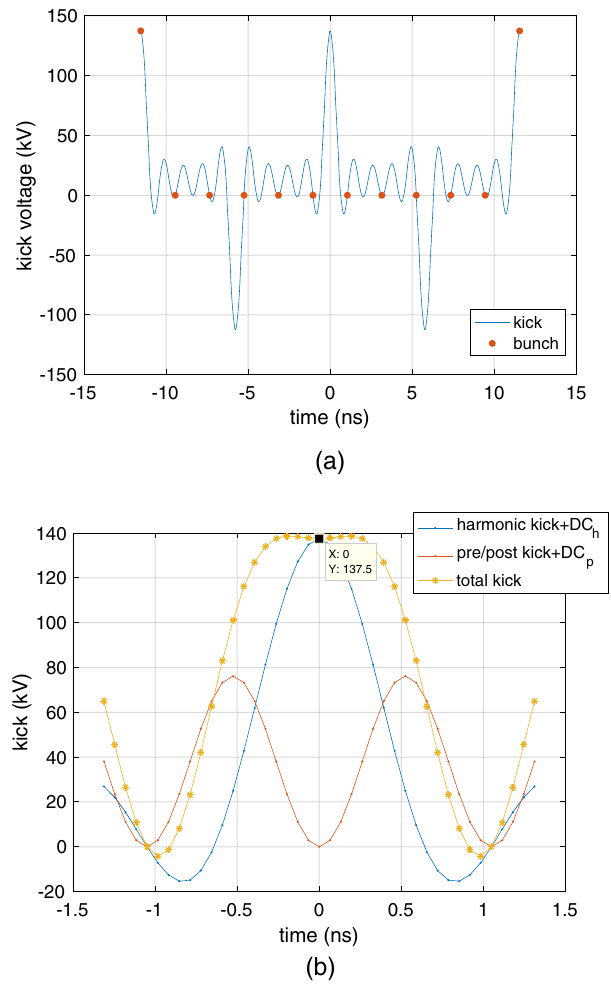
FIG. 3. The profiles of the designed kicks. (a) The temporal profile of a harmonic kick. The red dots correspond to electron bunches arrriving at the kicker every 2.1 ns. While the kick frequency is 86.6 MHz, the electron bunch in current scheme is injected into the CCR at a frequency of 43.3 MHz. We have introduced a DC kick to uniformly reduce the residual kicks to zero. (b) The temporal profile of kick after addition of pre/post ick.